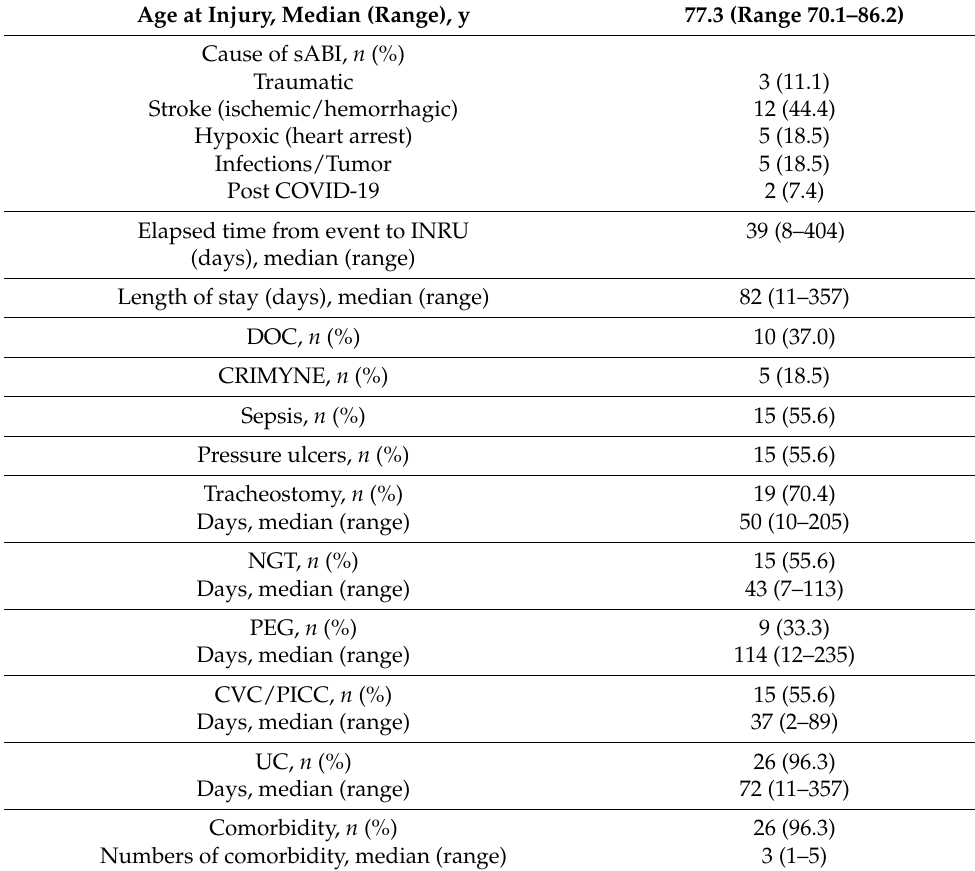
Table 1. Patient features at baseline (N =